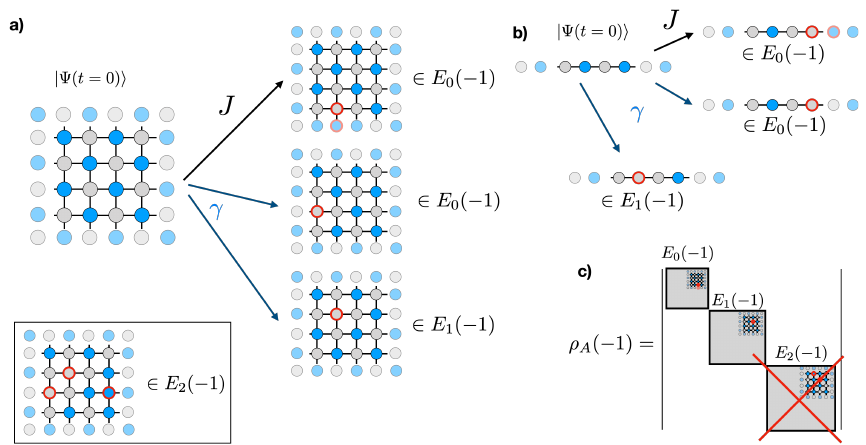
Figure 3: Schematics of the short-time dynamics in lattice models considered here; we show here the sector with q = − 1. Panel a : the system is defined on a square lattice. The initial state is a charge-density wave | Ψ 〉 : grey and blue circles represent empty and full sites, respectively. At short time, the evolution involves states belong- ing to the E and E subspaces only (see examples, where sites circled in red are the 0 1 ones changed with respect to | Ψ 〉 ). The influence of the rest of the Hilbert space E proceeses starting from | Ψ 〉 . Panel b) : same as in panel a, but for the 1D case.